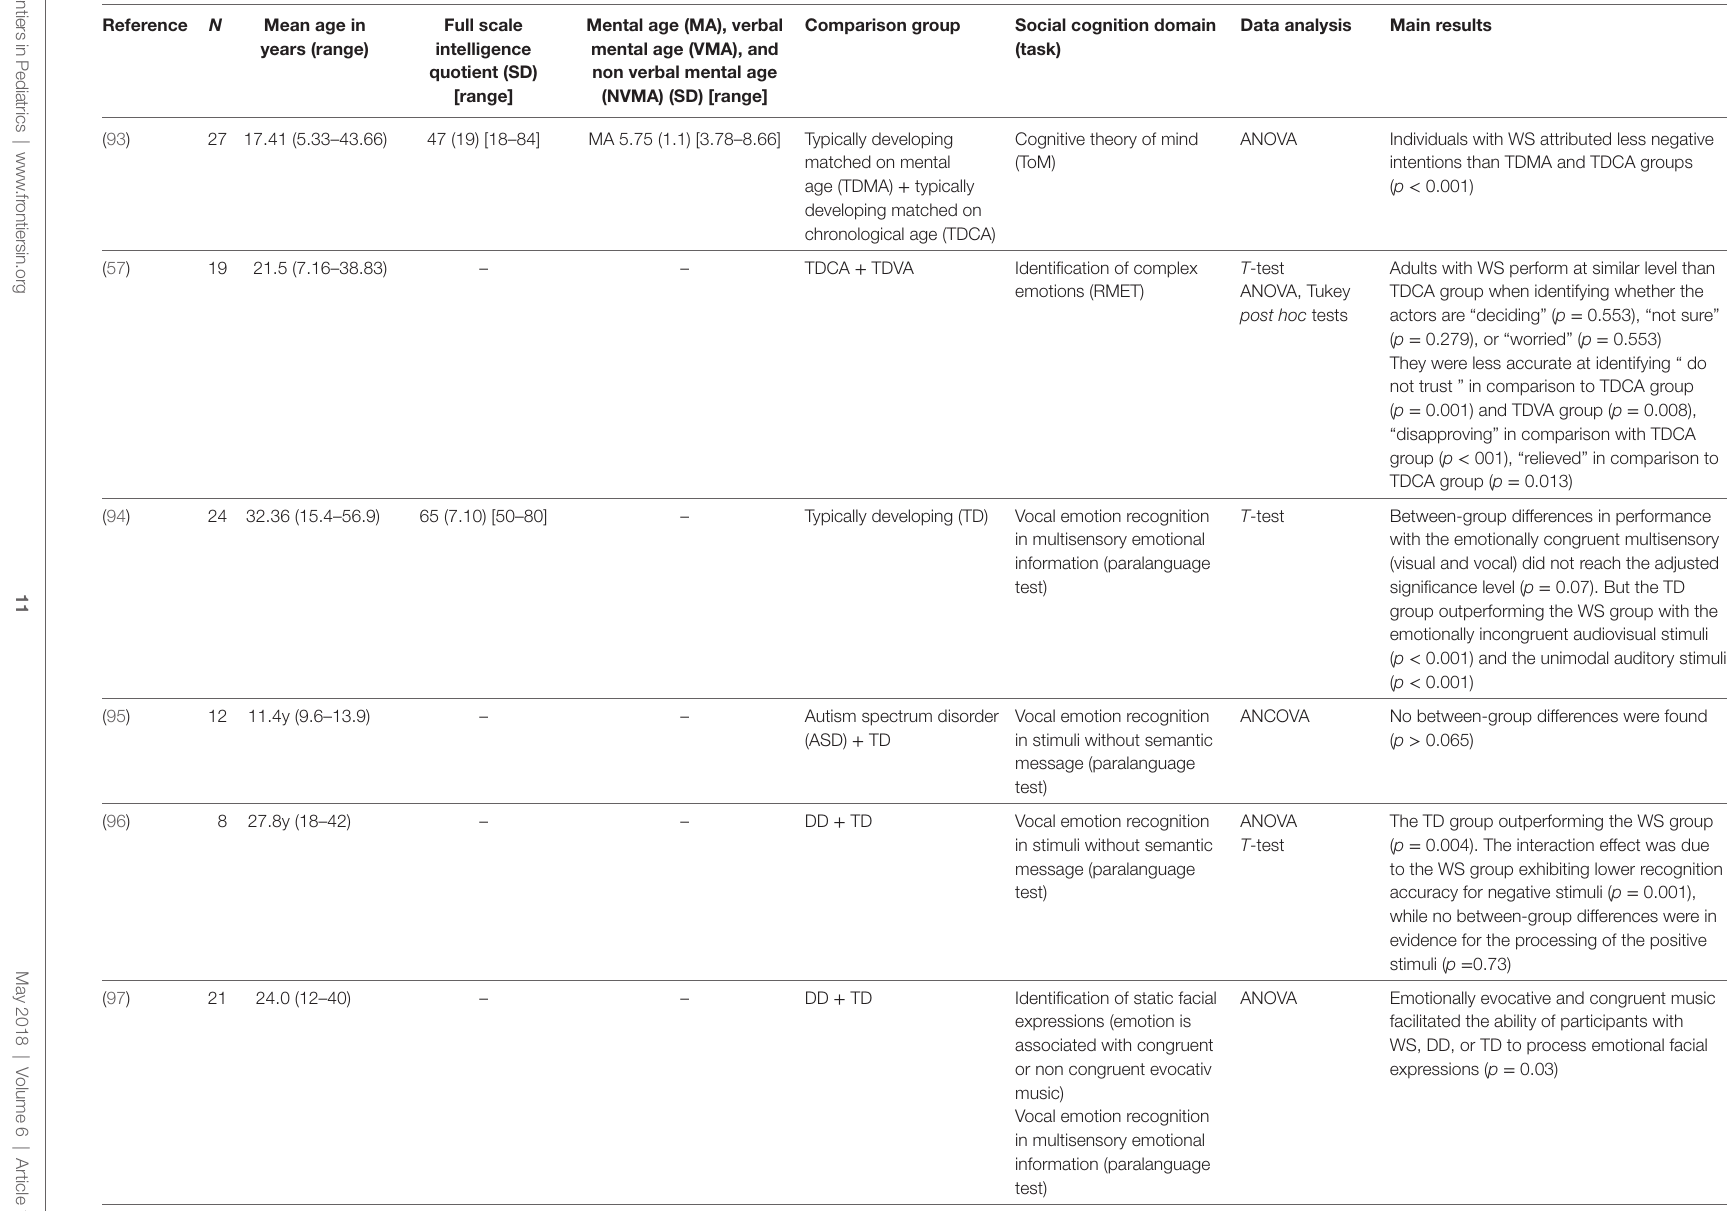
TAbLe 5 | Studies examining social cognition in Williams syndrome